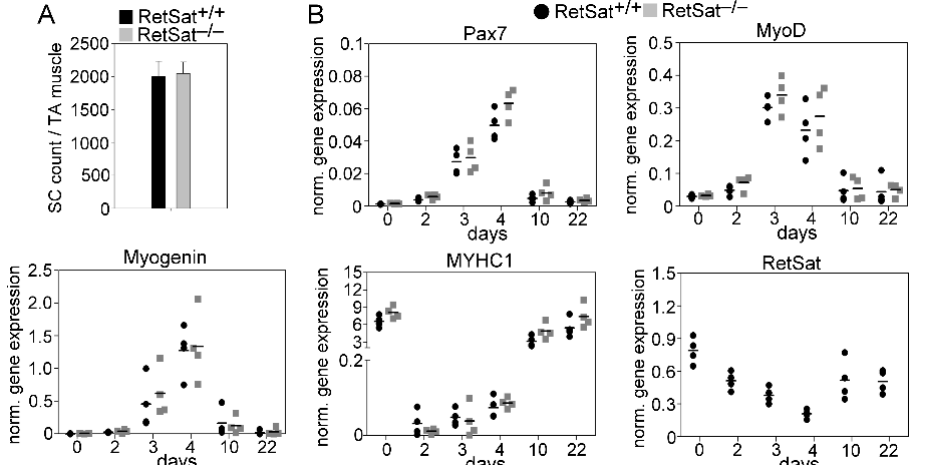
Figure 4. ( A ) The number of SC cells in the TA muscles at day 4 following CTX-induced injury, and ( B ) mRNA expression of RetSat and of various myogenic genes in the control and regenerating TA muscles of RetSat +/+ and RetSat − / − mice determined by qRT-PCR ( n = 4). 3.2. Decreased Recruitment of M ϕ s and Neutrophils after Injury in the Absence of RetSat Following injury, muscle repair is initiated by the migration of inflammatory cells to the injury site. To determine the composition of leukocytes in the early phase of muscle regeneration, we performed a flow cytometric analysis of magnetically separated CD45 + cells from collagenase digested muscles. In accordance with previous observations, we observed early infiltration of neutrophils at day 2 post-injury, followed by an increasing number of M ϕ s at days 3 and 4 in wild-type mice. However, in the absence of RetSat, a significantly decreased number of CD45 + cells infiltrated the injured muscle (Figure 5A). In line with this observation, at day 2 post-injury, a significantly decreased gene expres- sion level of monocyte chemoattractant protein-1 (MCP-1) was detected (Figure 5B), whereas the neutrophil/M ϕ ratios did not change (Figure 5C).